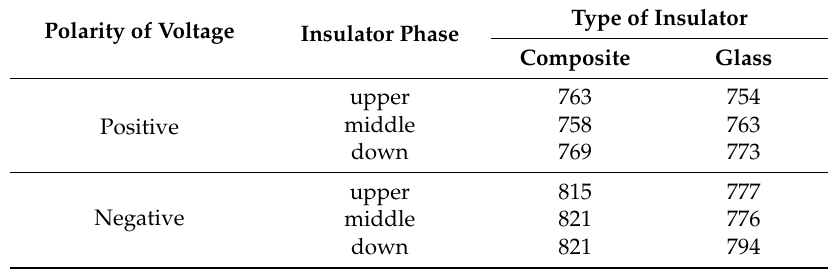
Table 2. The data are corrected for atmospheric effects and the length discrepancy of different insulators. Table 2. The U 50% of composite/glass insulator with standard lightning impulse